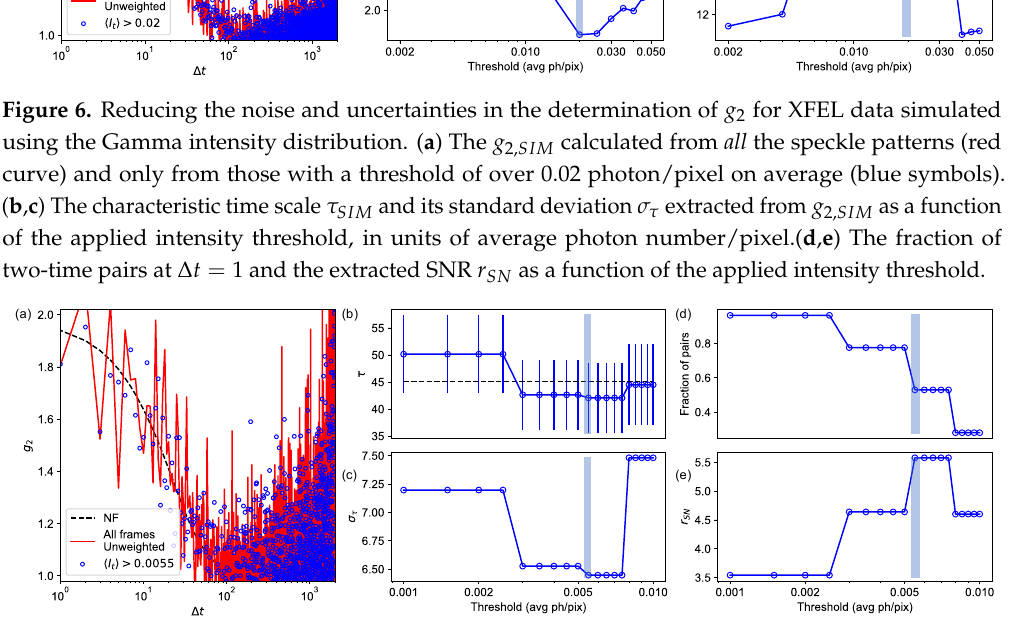
Figure 7. Reducing the noise and uncertainties in the determination of g 2 for the simulated data in Figure 2a with an average of 0.01 photons/pixel. ( a ) The g 2, SIM calculated from all the speckle patterns (red curve) and only from those with a threshold of over 0.0055 photon/pixel on average (blue symbols). ( b , c ) The characteristic time scale τ SIM and its standard deviation σ τ extracted from g 2, SIM as a function of the applied intensity threshold, in units of average photon number/pixel. ( d , e ) The fraction of two-time pairs at ∆ t = 1 and the extracted SNR r SN as a function of the applied intensity